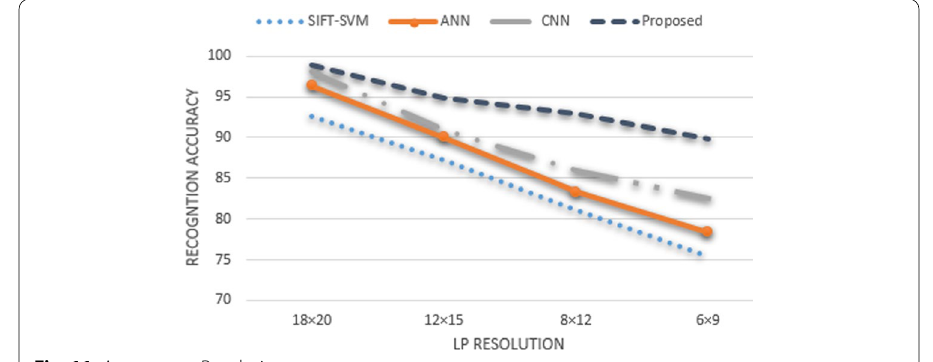
Fig. 11 Accuracy vs